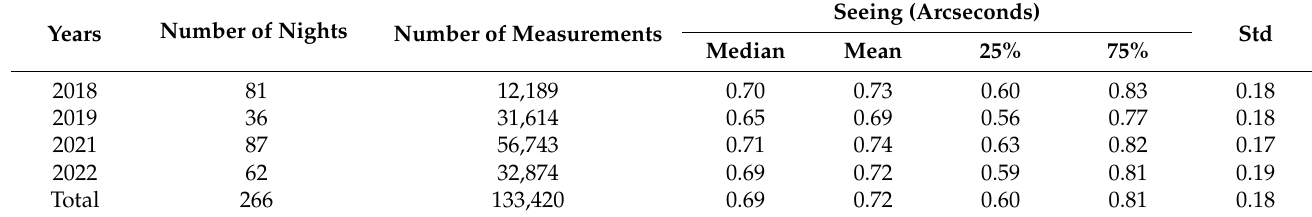
Table 1. Yearly statistics of seeing at Maidanak Observatory for 2018–2022.